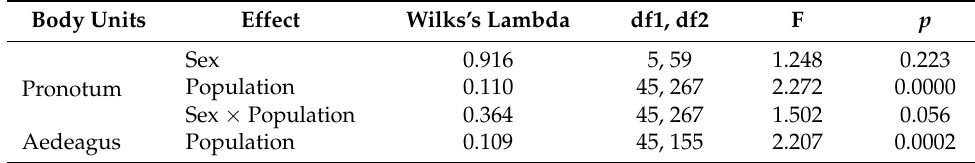
Table 3. Multivariate analysis of variance (MANOVA) performed for shape variables of pronotum and aedeagus of Pterostichus brevicornis brevicornis (df1—model degrees of freedom; df2—error degrees of freedom). Differences statistically significant at p <